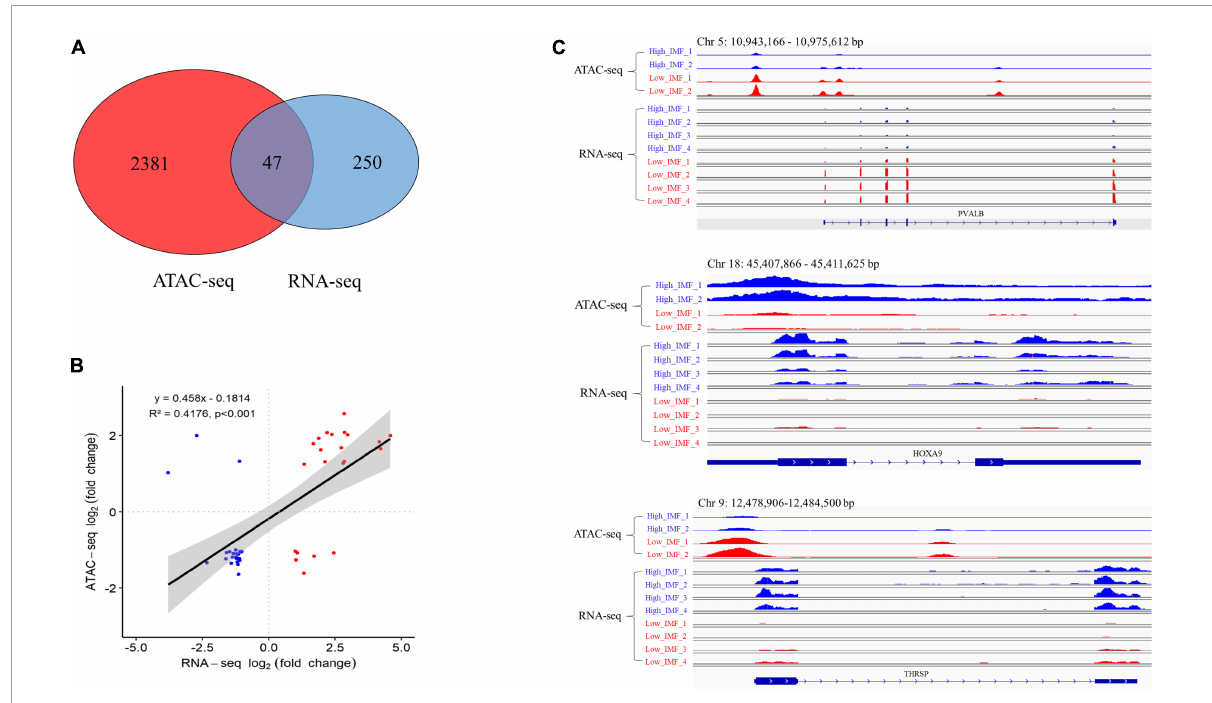
FIGURE4 Integration analysis of ATAC-seq and RNA-seq results. (A) Overlap of differentially expressed genes identified by ATAC-seq and RNA-seq. (B) Correlation of significantly differentially accessible gene (ATAC-seq) and gene expression (RNA-seq). (C) IGV snapshot for ATAC-seq and RNA-seq signal for the PVALB , HOXA9 and THRSP gene.